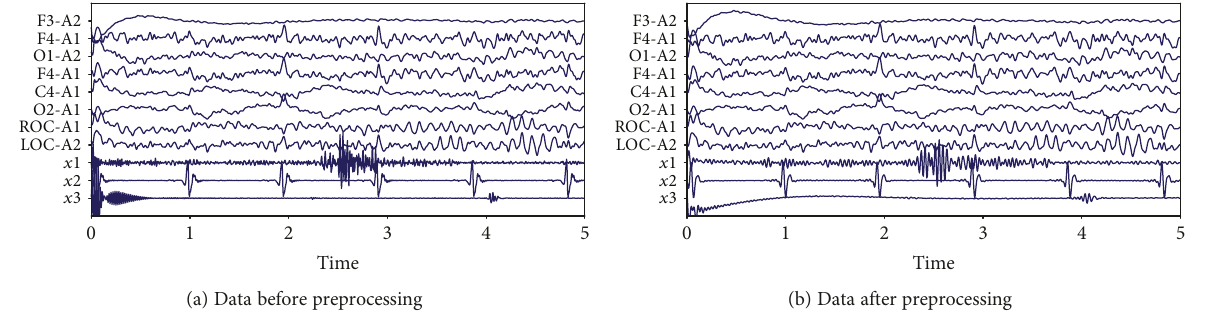
Figure 2: Data before and after preprocessing.